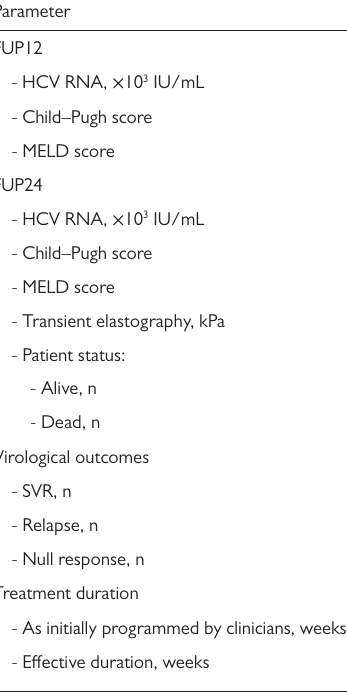
Table 3. Main Clinical and Virological Parameters of Patients After Antiviral Treatment, n = 147